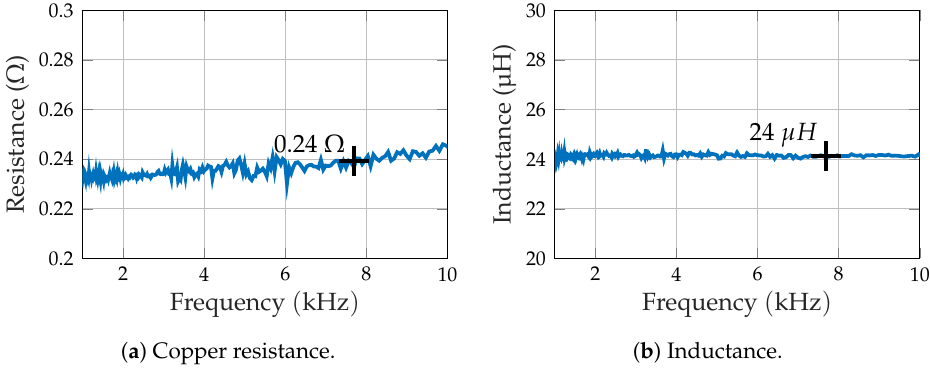
Figure 2. Impedance of the primary excitation